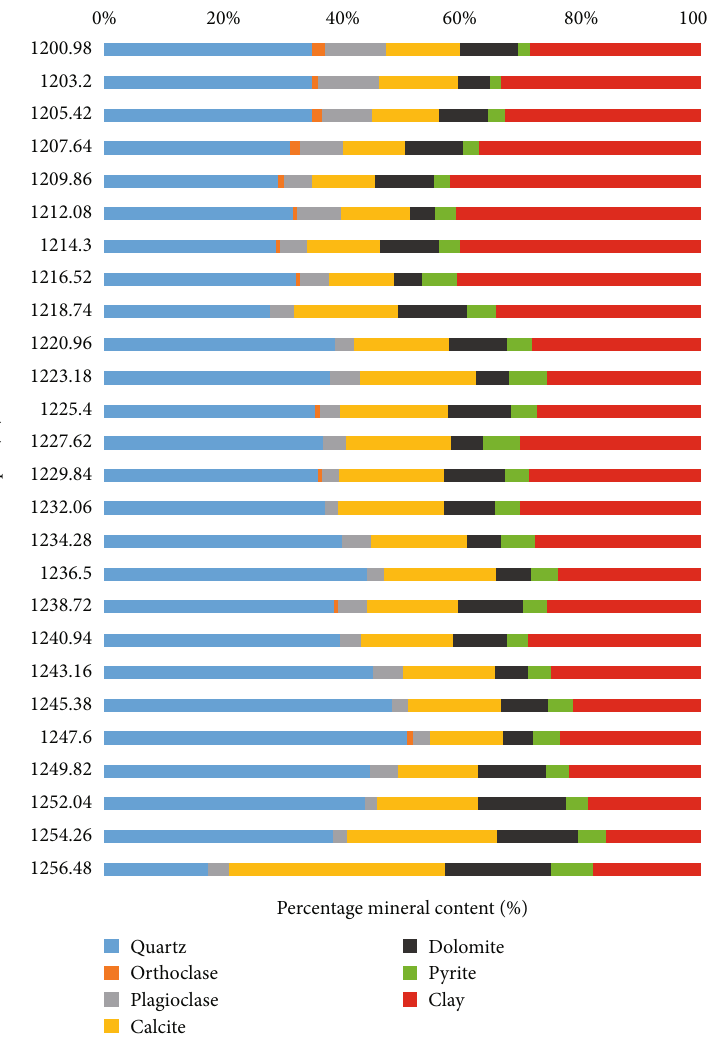
Figure 5: Vertical distribution of LF mineral components in well